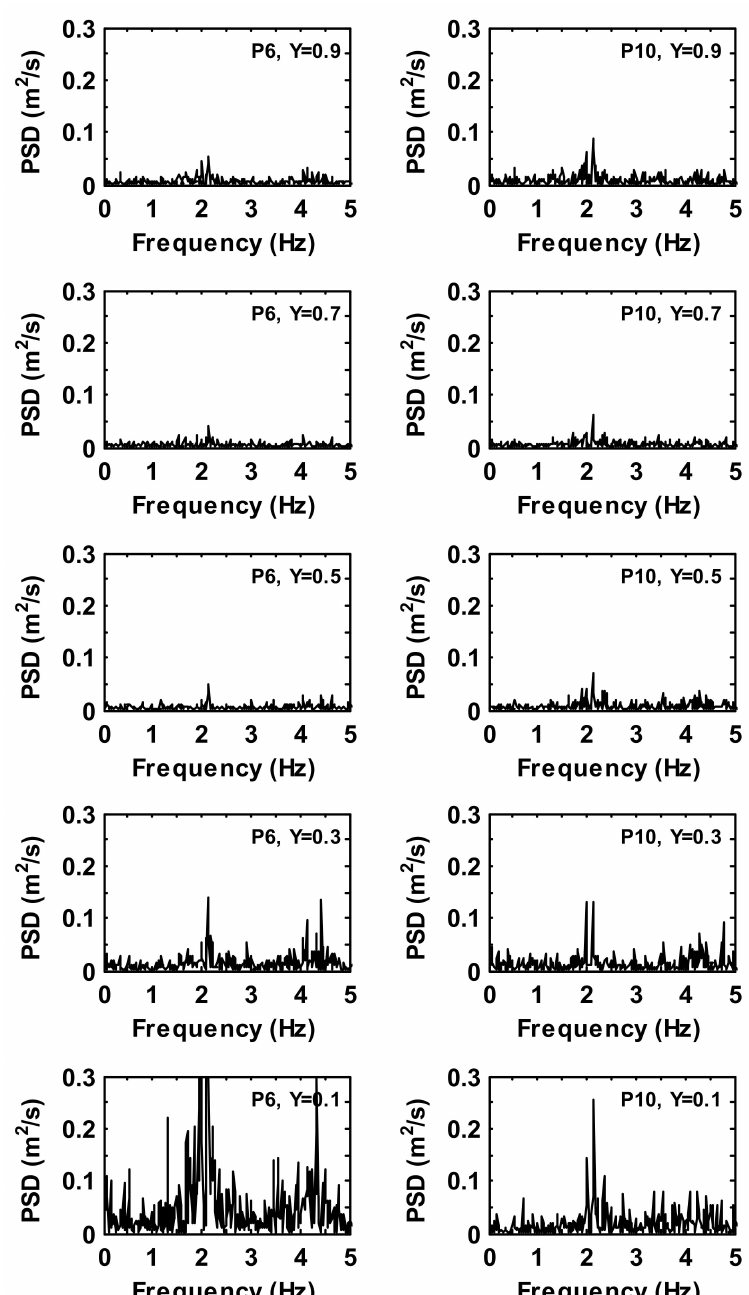
Figure 11. Power spectra density of the time history velocity magnitude fluctuations at monitoring locations P 6, P 10 for case